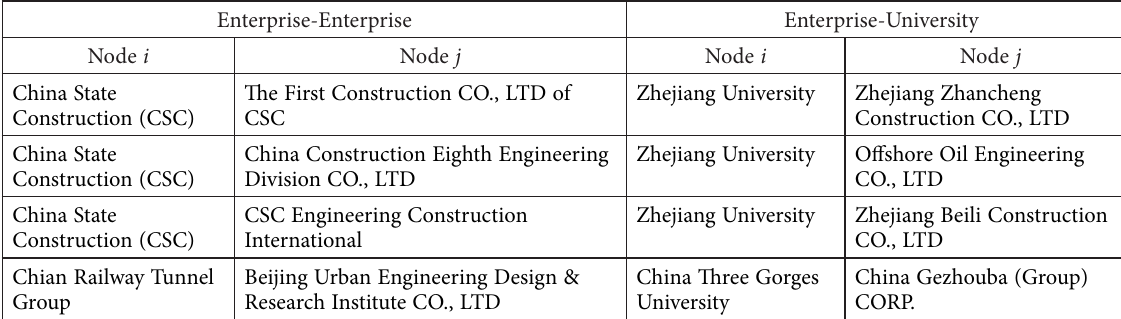
Table 1. An example of data excerpts: cooperative enterprises or